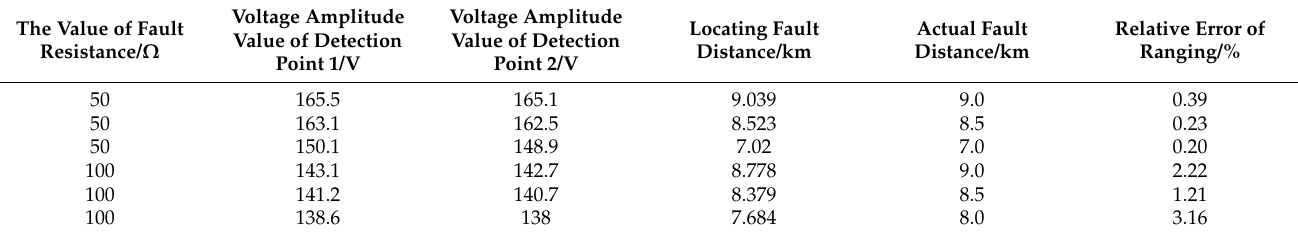
Table 3. Analysis of fault location results.